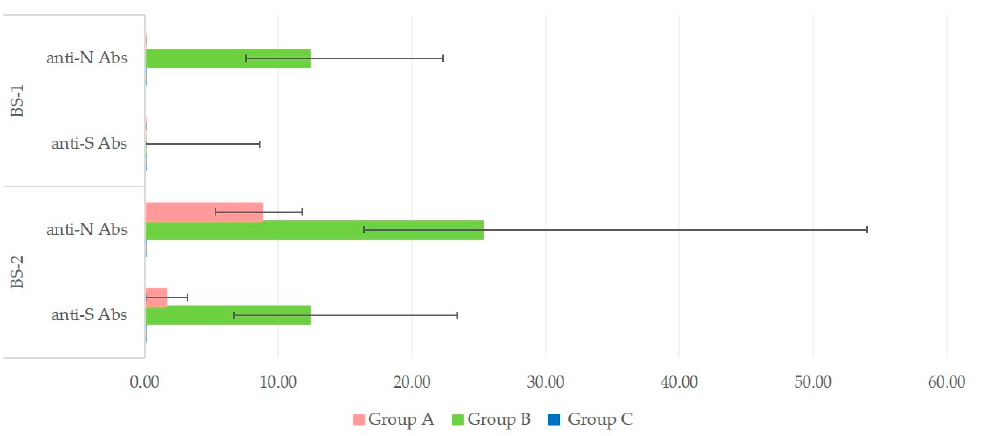
Figure 2. Median values of anti-nucleocapsid (anti-N) and anti-spike (anti-S) antibody titers in blood samples collected 15 days apart, BS-1 and BS-2 (bars indicate min.–max. values).